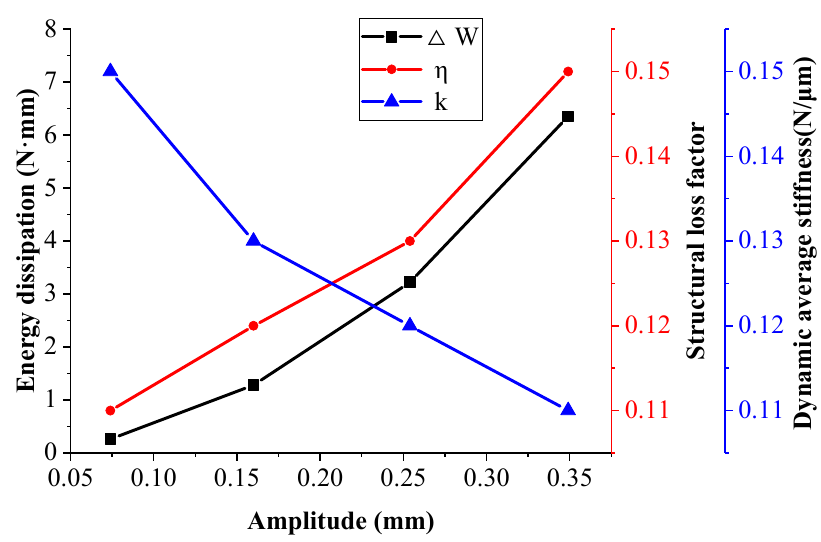
Figure 9. Test data processing results of group 2 (f = 10 Hz).